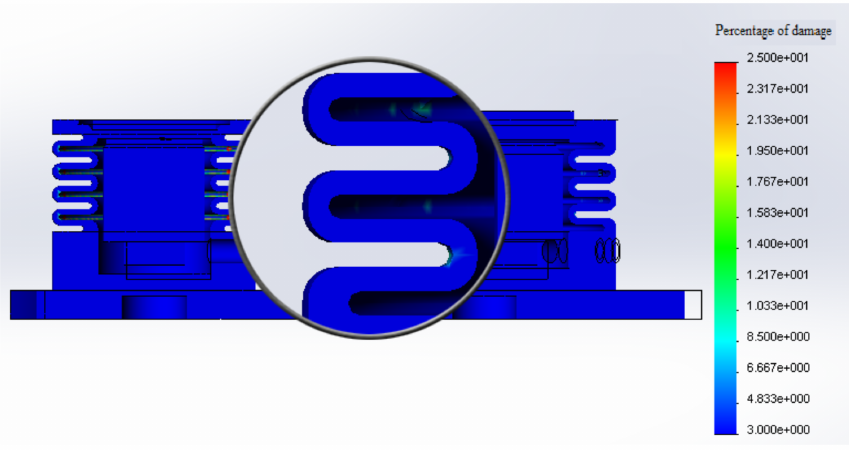
Figure 7. Percentage of damage of the thrust bearing